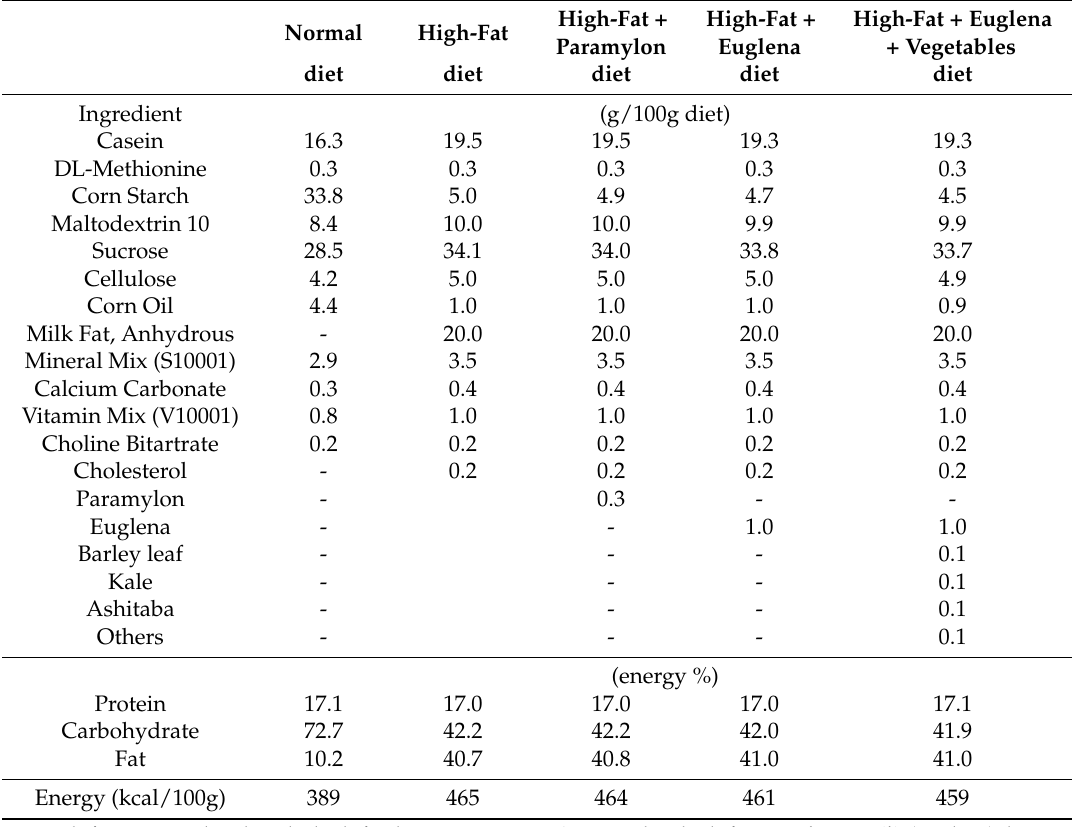
Table 1. Composition of test